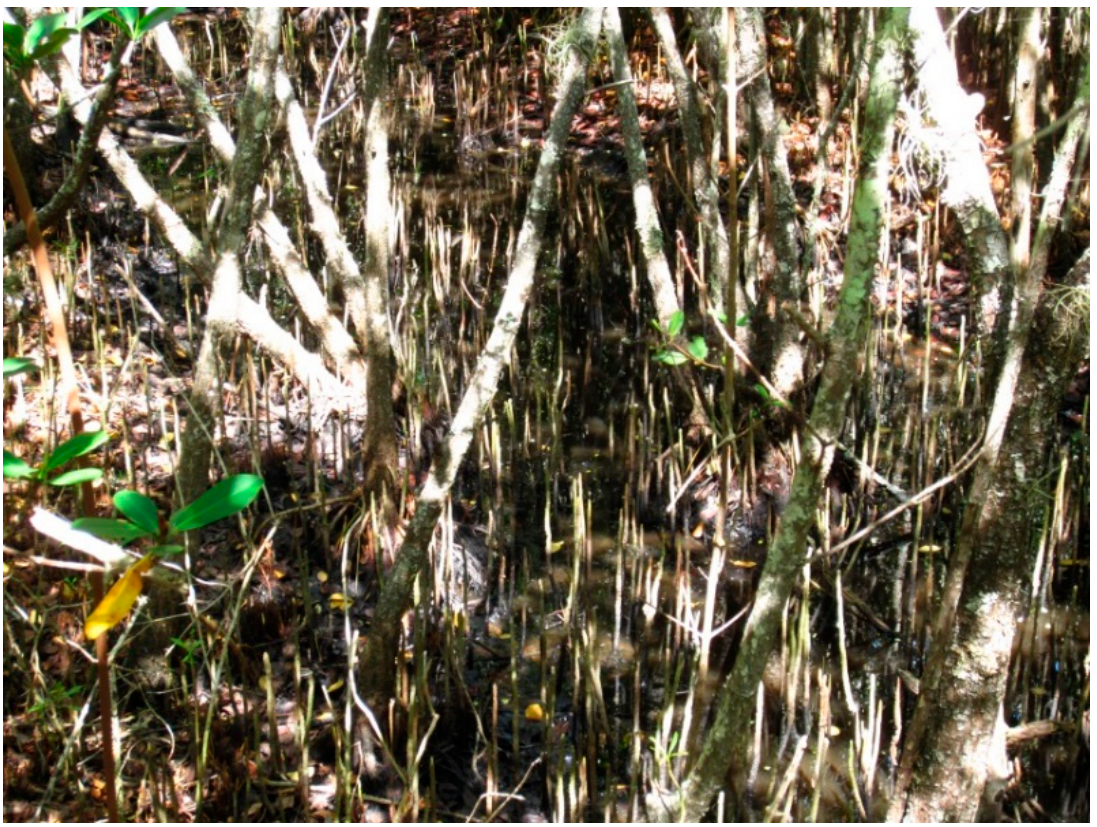
Figure 2. High water mark in a black mangrove ( Avicennia germinans (Linnaeus) Linnaeus) forest in south Florida where Aedes taeniorhynchus females prefer to oviposit in the leaf litter above the standing water.